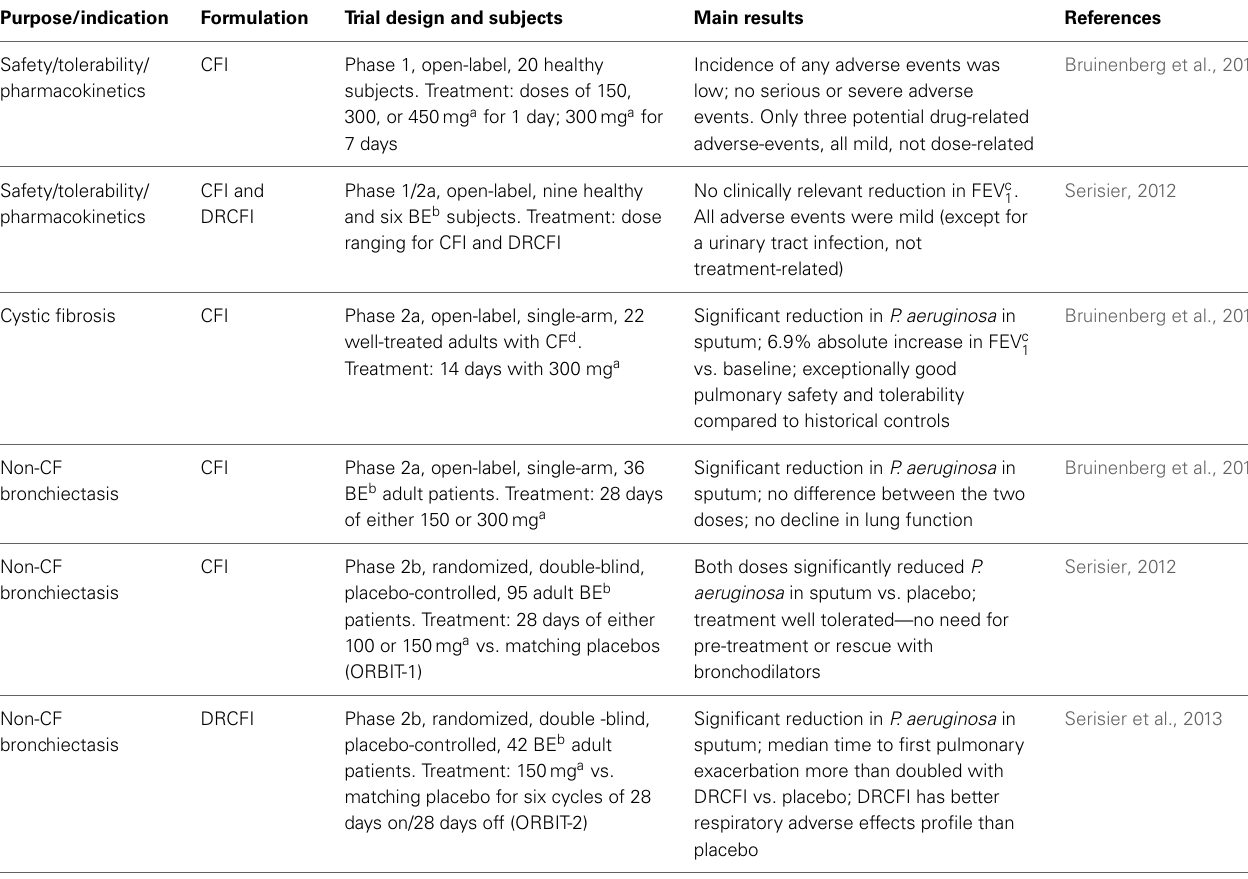
Table 1 | Clinical phase 1 and 2 trials evaluating once daily dosing with CFI or DRCFI for treatment of patients with chronic Pseudomonas aeruginosa